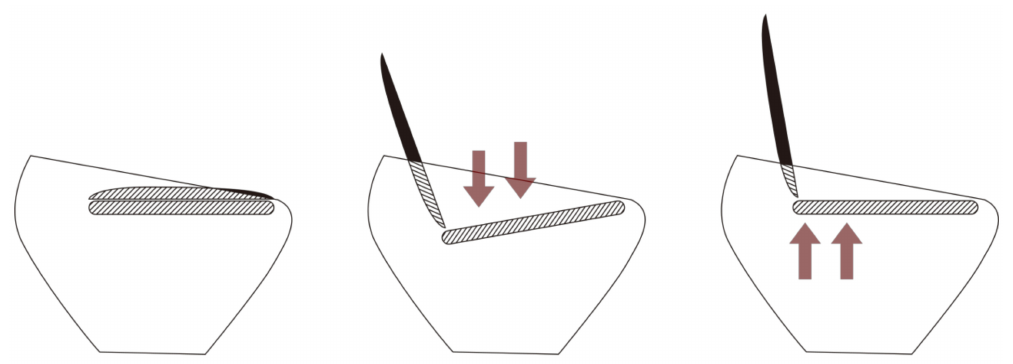
Figure 4. Working process of the seat of the waterless toilet